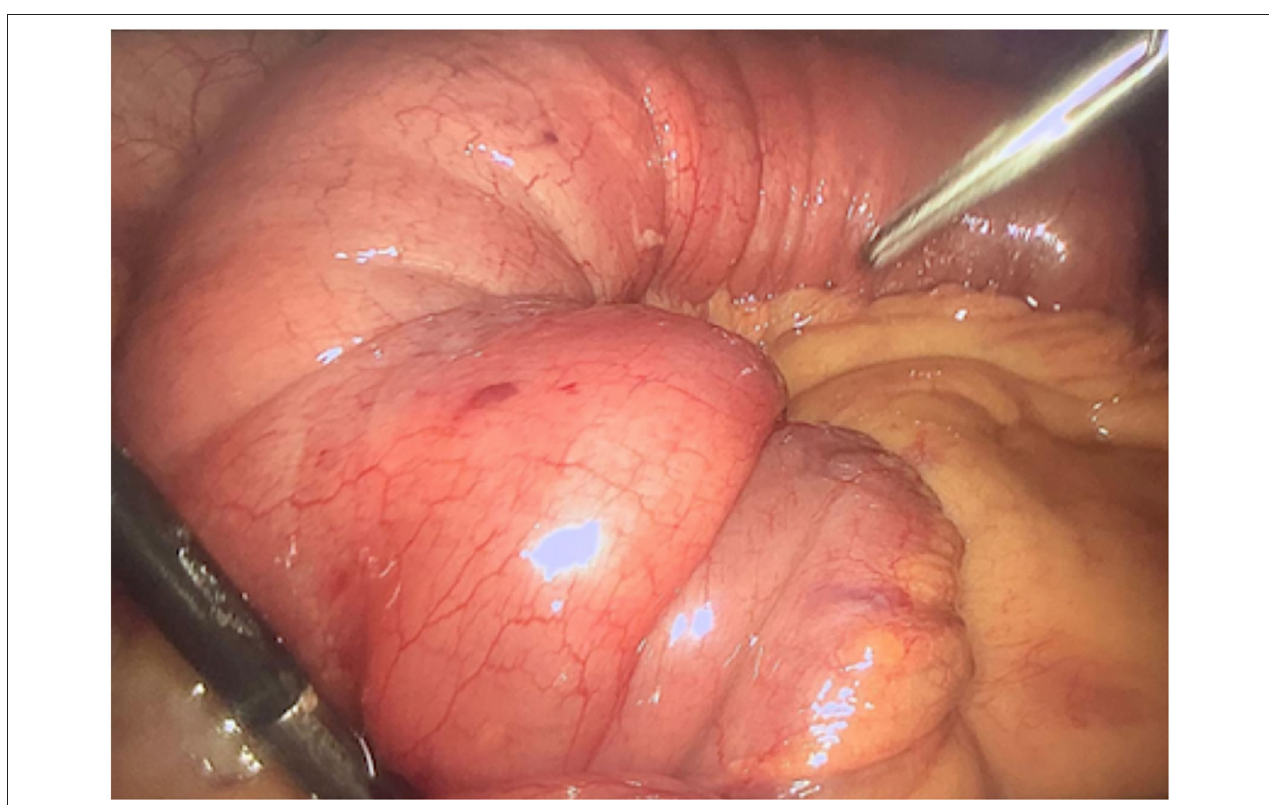
FIGURE 3 | Laparoscopic view of the ileo-ileal invagination: “sausage-shaped”